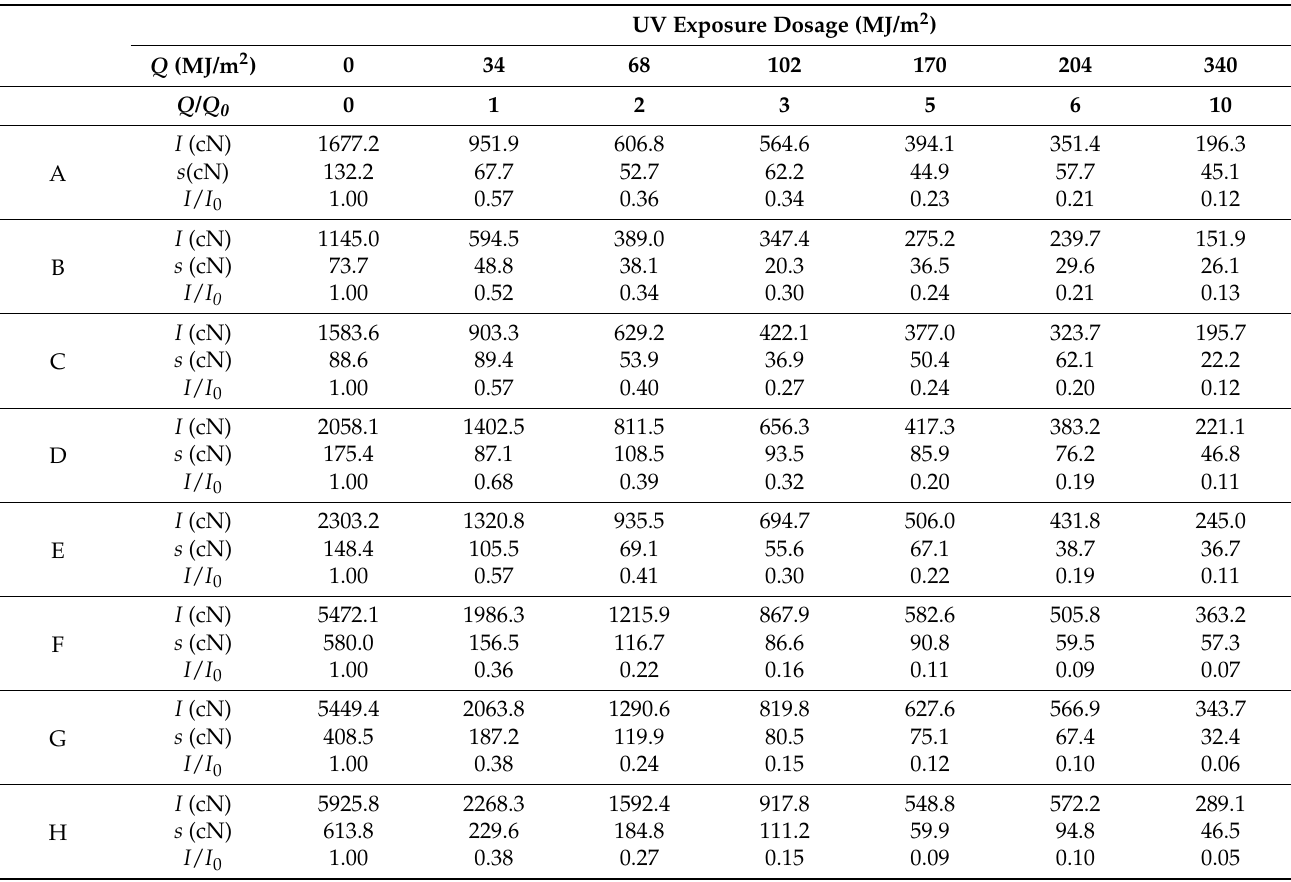
Table 3. Tensile strength and the retention fraction of tensile strength for m-Aramid/p-Aramid blending yarns.